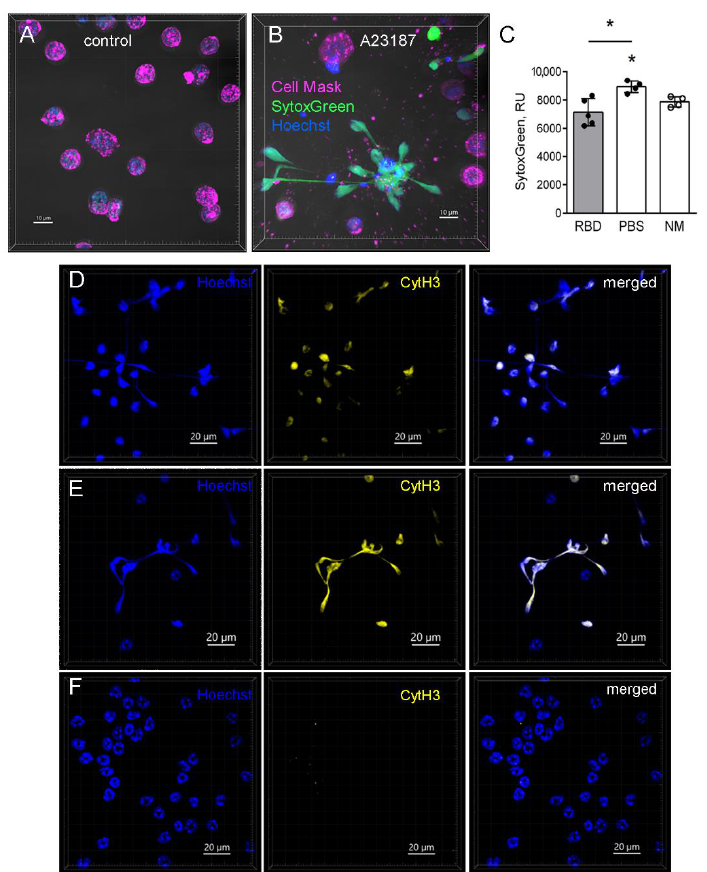
Figure 5. NET formation by bone marrow neutrophils from mice with RBD–specific antibodies. ( A , B ) The representative images of neutrophils yielded from the bone marrow of the PBS–injected mouse 3 h after the incubation in the presence ( B ) or without ( A ) of 5 µm of A23187. The neutrophils were stained with Cell mask (magenta), SytoxGreen (green), and Hoechst (blue). Scale bar 10 µm. ( C ) The quantitative analysis of the extracellular nucleotide levels 3 h after the incubation with A23187 of neutrophils from the bone marrow of mice injected with RBD (gray bars, black circles), PBS (open bars, black circles) or intact mice (open bars, open circles). Data are shown as medians and i.q.r. for n ≥ 4 mice per group. A significant difference between the indicated group and the intact mice or between the indicated groups was detected using the Mann–Whitney test *: p ≤ 0.05. ( D – F ). The representative images of nuclei (Hoechst, left images), citrullinated histone H3 (CytH3, middle images), and co-localization (merged, right images) are presented for the A23187–treated ( D , E ) and untreated neutrophils ( F ), yielded from RBD–injected ( D ) or PBS-injected ( E , F ) mouse 24 h after the application of 100 nm particles in the RBD solution. Scale bar 20 µ